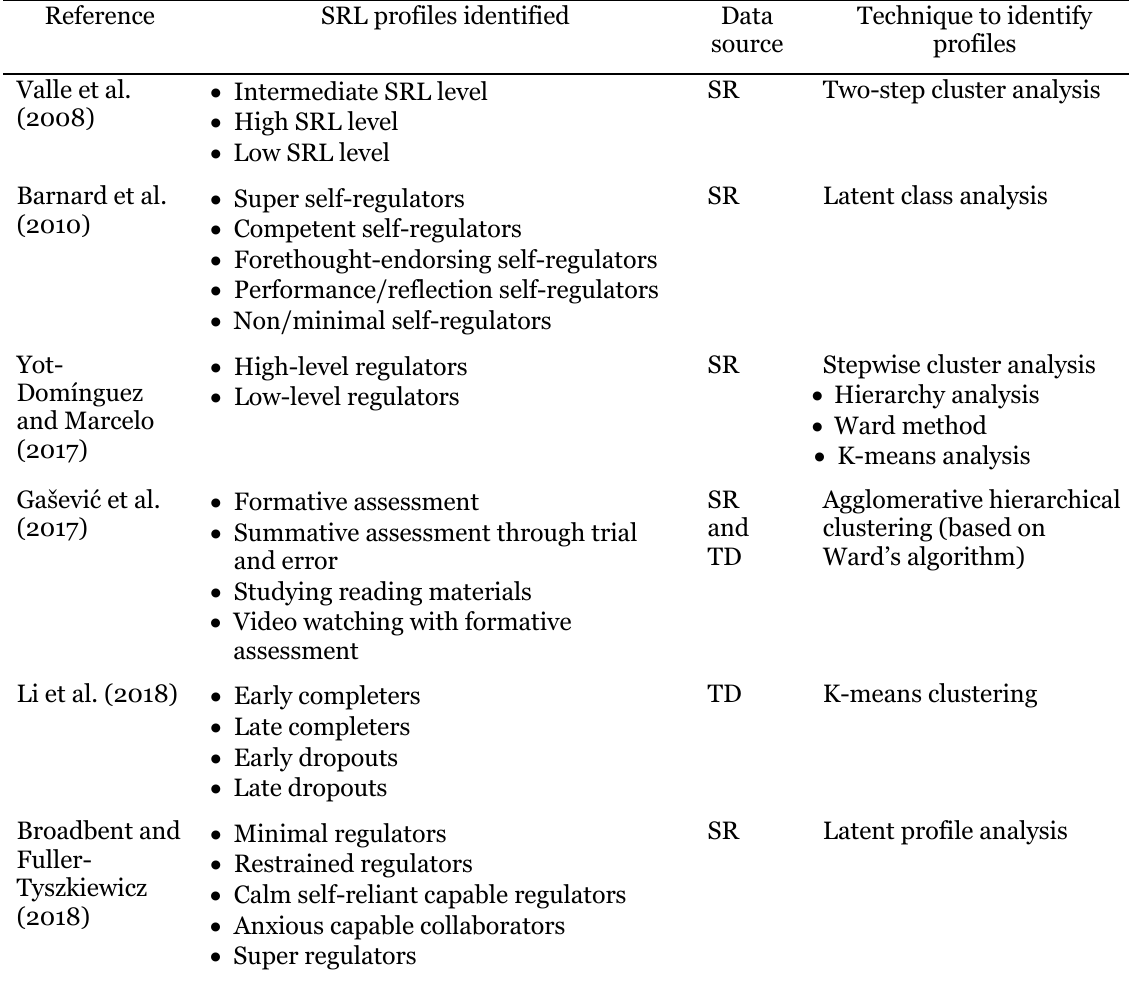
Summary of SRL Profiles Identified From Previous Studies